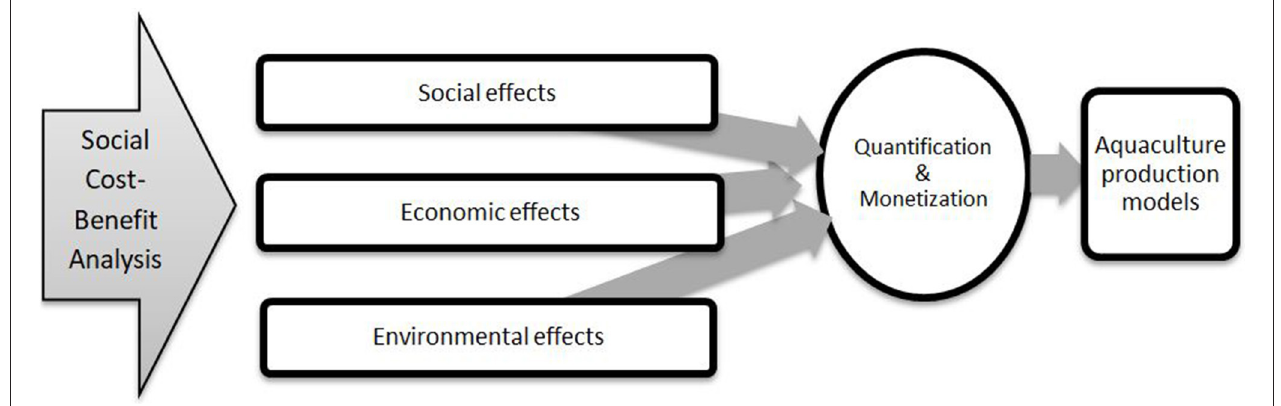
FIGURE 1 | Identification of socio-economic and environmental impact of aquaculture and their integration to aquaculture production